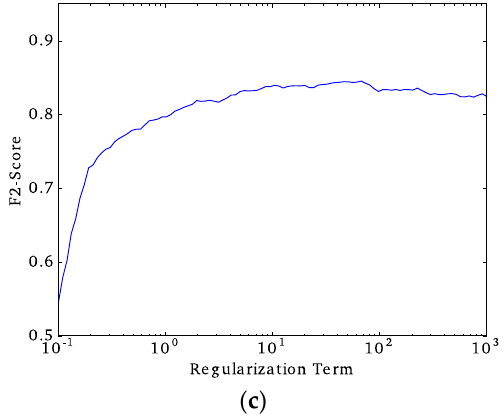
Figure 8. Tuning the regularization terms: ( a ) Buenos Aires; ( b ) Medellin; and ( c ) Recife.